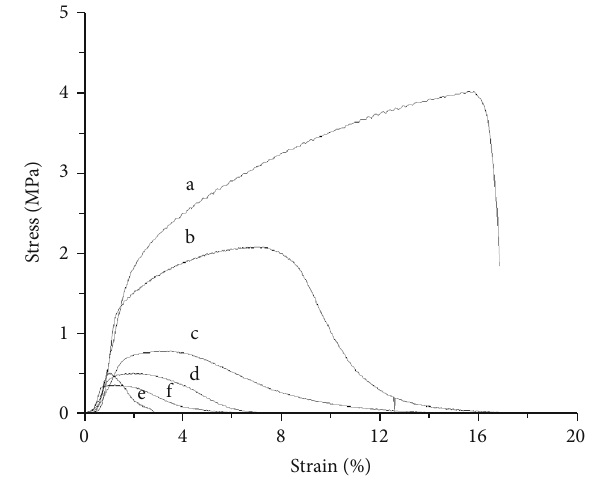
Figure 3: Stress-strain curve of POM/ β -CD micro fi ber fi lms with di ff erent contents of β -CDs: (a) 0wt.% β -CDs, (b) 10 wt.% β - CDs, (c) 20 wt.% β -CDs, (d) 30 wt.% β -CDs, (e) 40wt.% β -CDs, and (e) 50wt.% β -CDs.